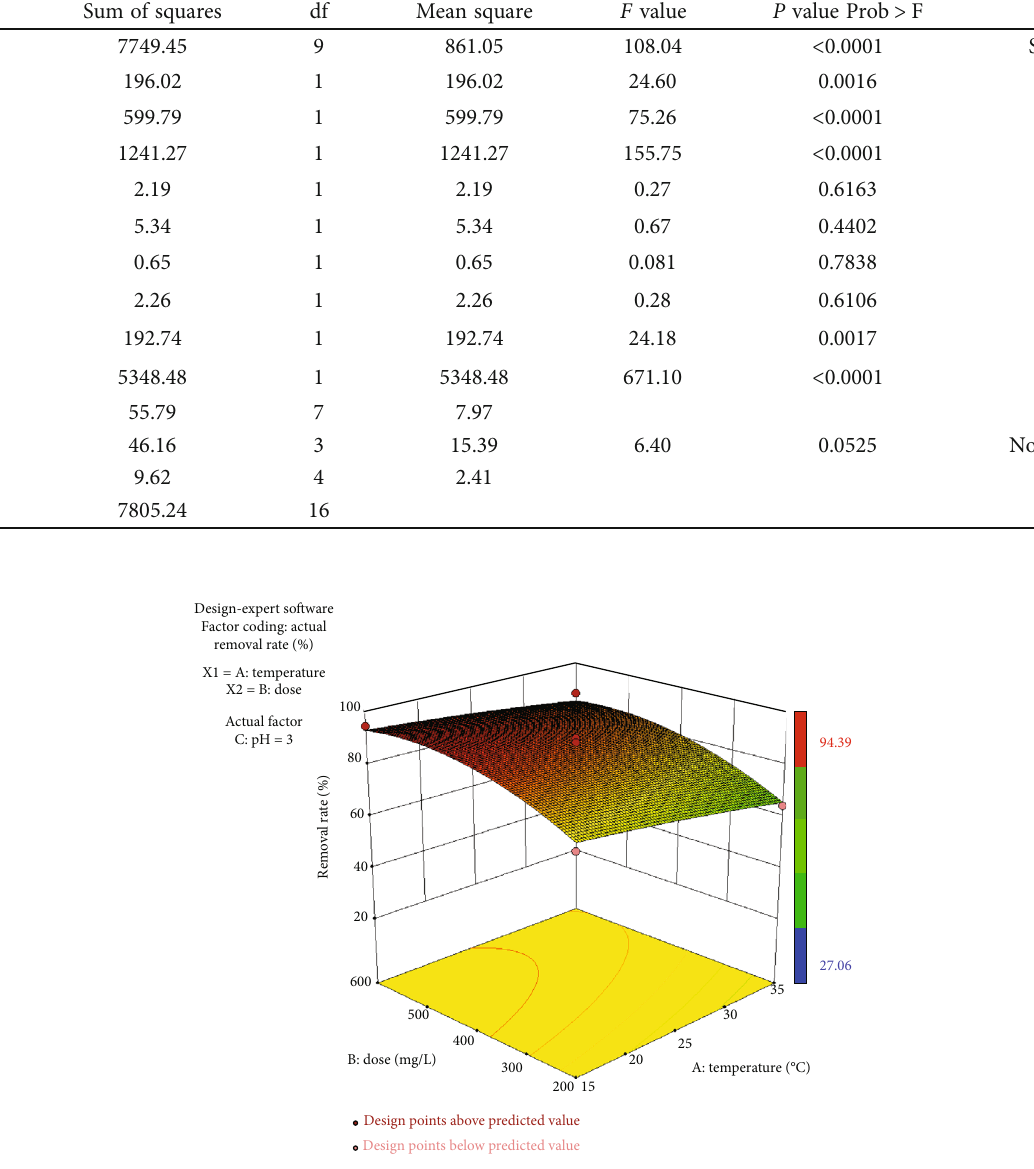
Figure 4: Responsive surface map of removal percentage for temperature and adsorbent